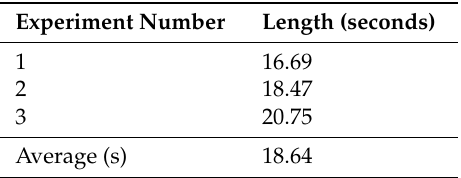
Table 2. Total Length in Seconds for the First Three Experiments.